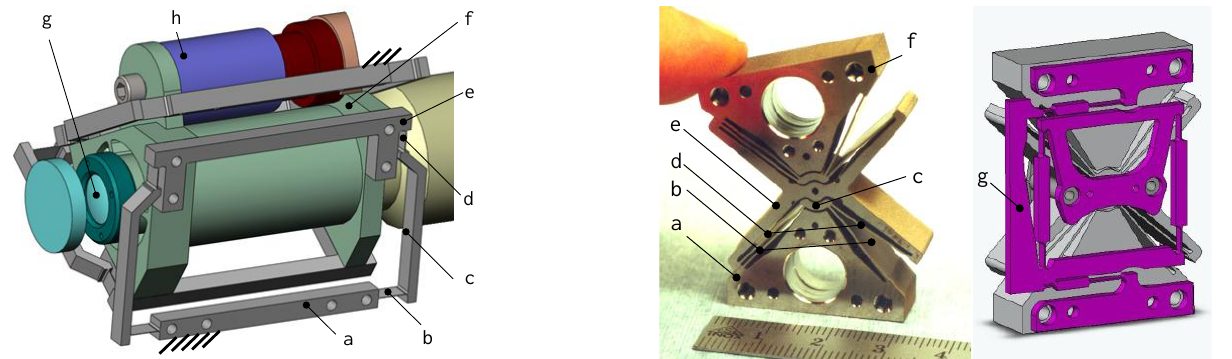
Figure 4. Left: Rectilinear flexure mechanisms of the Mars Close-up Imager. Center: Picture 2 Figure 4. Left: rectilinear flexure mechanisms of the Mars Close-up Imager. Center: picture of the monolithic Butterfly flexure pivot (angular stroke up to ± 15 ◦ ; centre shift below 2 microns). Right: Butterfly Pivot equipped with a slaving of the monolithic Butterfly flexure pivot (angular stroke up to +/- 15°; centre shift below 2 3 microns). Right: Butterfly Pivot equipped with a slaving plate. 4